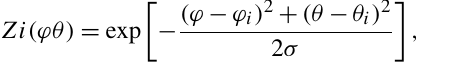
where we set characteristic length σ as 5 km (NASA, 2022). The bathymetric data are from the GEBCO 2019 with 15 arcsec resolution (General Bathymetric Chart of the Oceans, downloaded from https://www.gebco.net, last ac- cess: 1 April